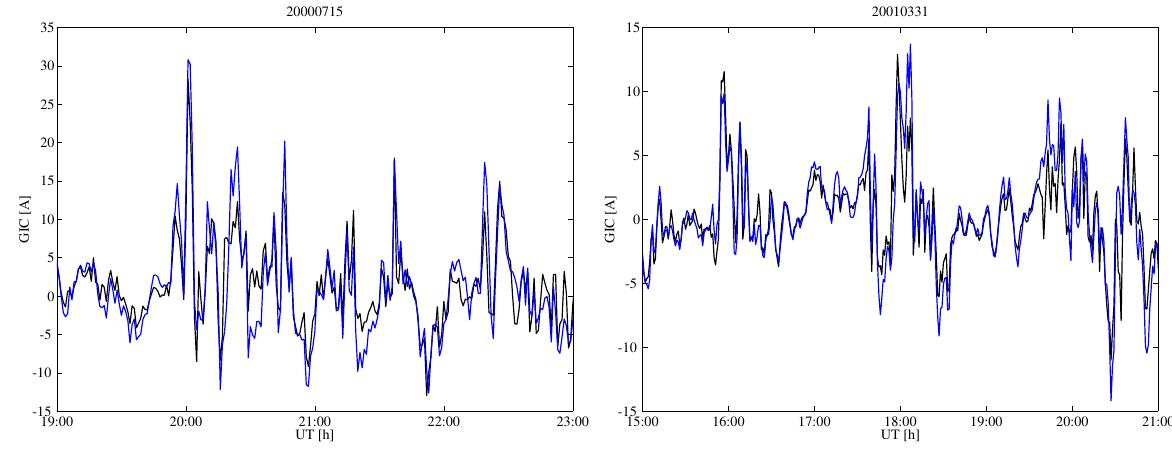
Fig. 8. Measured (black line) and modelled (blue line) geomagnetically induced currents at the Rauma (RAU) and Yllikk¤al¤a (YLL) 400 kV transformer stations on April 11, 2001.